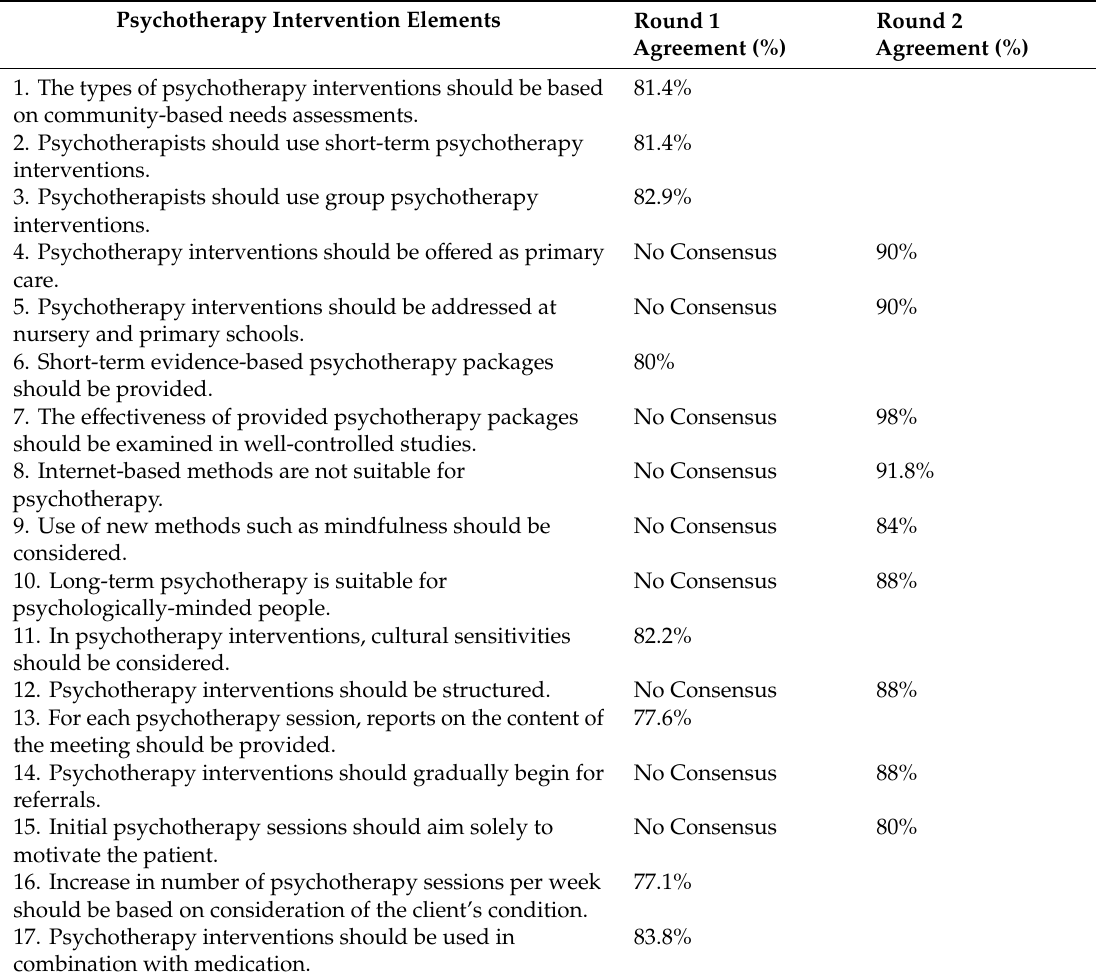
Table 4. Results of rounds 1 and 2 for psychotherapy